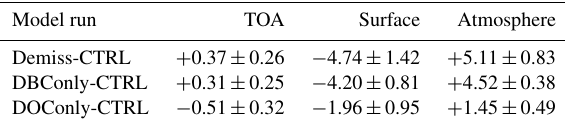
Table 1. ECHAM6 HAM simulated total (shortwave and longwave) radiative forcing (Wm − 2 ) along with 2 standard deviation values averaged over the TP and Indo-Gangetic Plain (80–110 ◦ E, 15– 35 ◦ N)